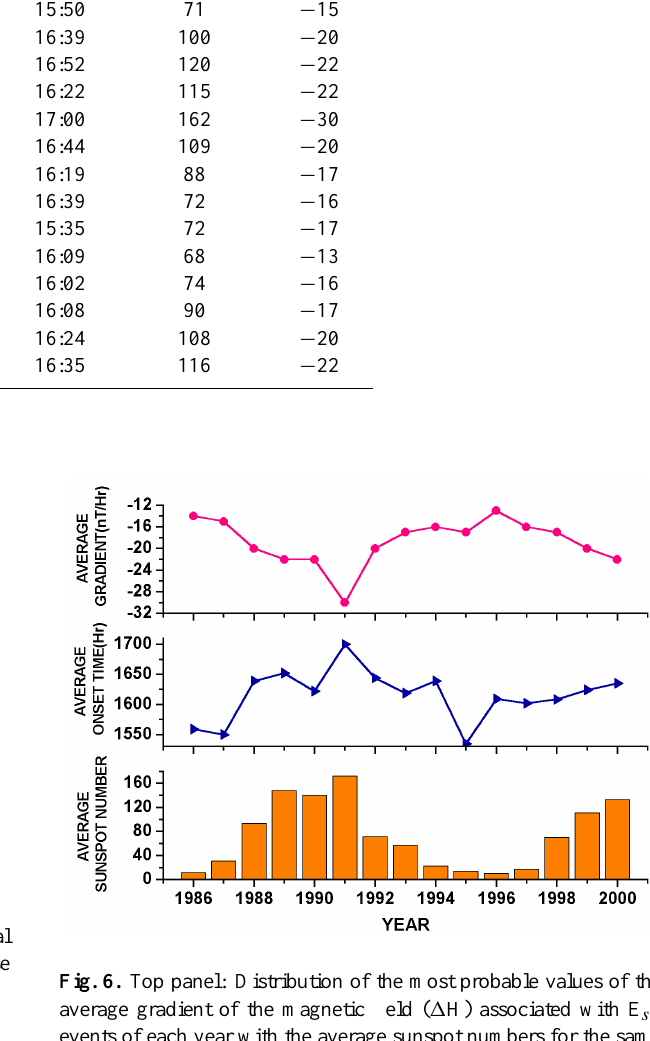
average gradient of the magnetic field ( 1 H) associated with E sb events of each year with the average sunspot numbers for the same days of each year. Bottom panel: Distribution of the most probable onset time of the E sb events with the average sunspot numbers for the same days of each